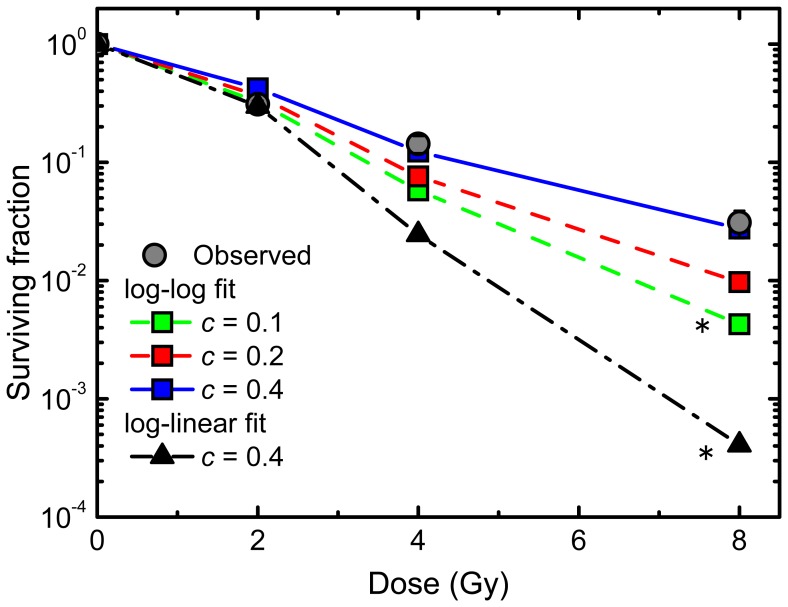
Surviving fraction estimated from the simulations of abortive colonies.Circles demonstrate the experimentally determined surviving fraction, and lines with squares represent the simulated surviving fraction with the specific slope c (0.1, 0.2 and 0.4) using the parameters of the log-log fit. Lines with triangles indicate the simulated ones using the parameters of the log-linear fit (c = 0.4). Asterisks indicate significant differences (p<0.05) between observation and simulation tested by the Chi square test with the Bonferroni correction.